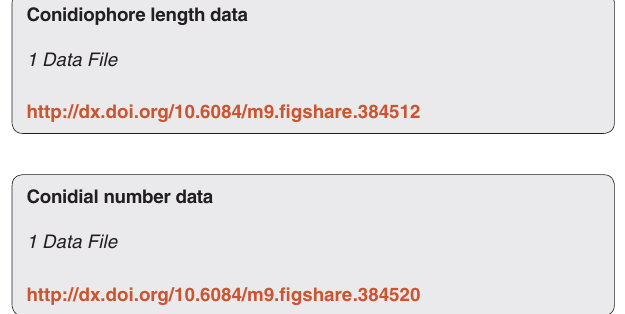
Figure 3. Sterigmatocystin (A) and penicillin (B) production in xprG loss-of-function ( xprG - ) and gain-of-function ( xprG1 ) mutants. A . Sterigmatocystin, extracted from the filtered growth medium of an xprG + strain (MH2), an xprG1 strain (MK85) and two xprG - strains, MK198 ( xprG2) and MK422 ( xprG D 1 ), was analyzed using thin layer chromatography. Sterigmatocystin fluoresces yellow after treatment with AlCl Sterigmatocystin (ST) (Sigma) was applied as a standard. The cultures used in the assays were generated by inoculating growth medium with 3 x 10 8 conidia. After transfer to carbon-free medium for 24 h, the dry mycelial weights were 100 mg ( xprG + ), 71 mg ( xprG1 ), 129 ( xprG2 ) and 152 mg ( xprG D 1 ). B . Penicillin bioassay based on inhibition of bacterial growth. Samples of filtered, concentrated growth medium from strains MH2 ( xprG + ), MK85 ( xprG1 ), and MK198 ( xprG2 ) was applied to wells in medium seeded with the Micrococcus luteus . 400 ng of penicillin G (penG) and 10 mM sodium orthophosphate buffer pH 6.8 (buffer) were used as controls. The Aspergillus growth medium contained either 3% glucose or 3% lactose. In the right-hand plate the samples were treated with 1 U of penicillinase (Sigma Aldrich) before they were applied to the wells. The full genotypes of the strains are given in Table